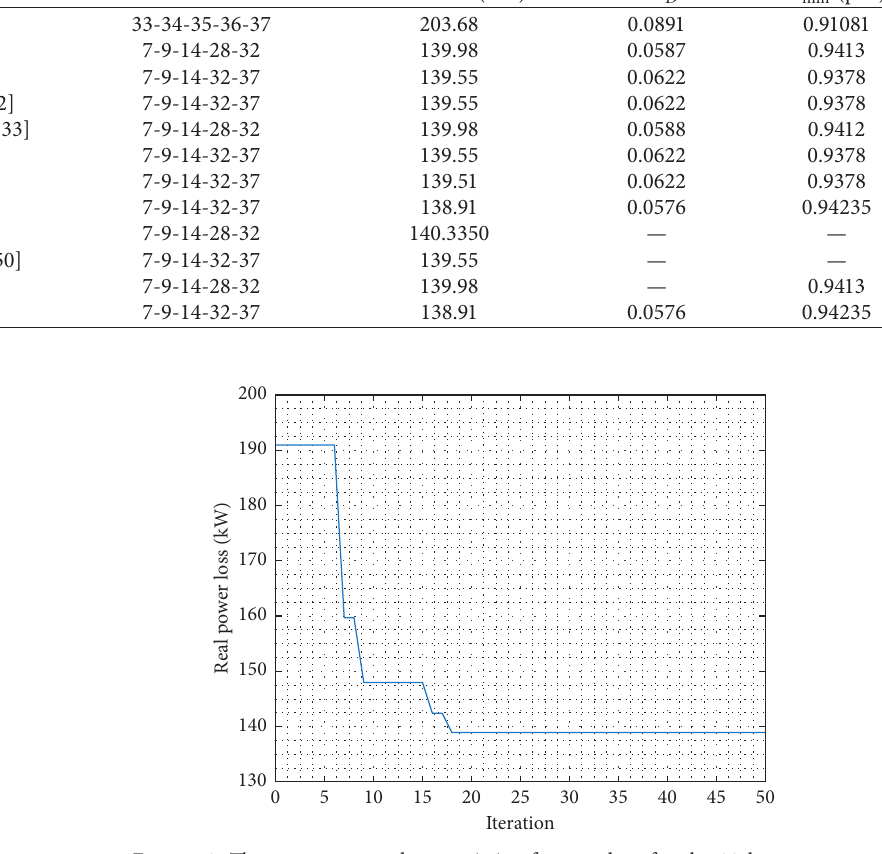
Figure 2: The convergence characteristic of power loss for the 33-bus